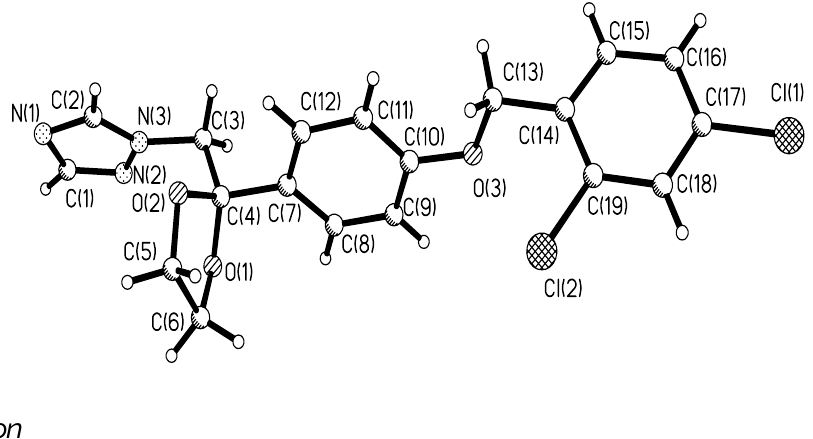
Figure 1. Molecular structure of compound 3g with the atomic numbering